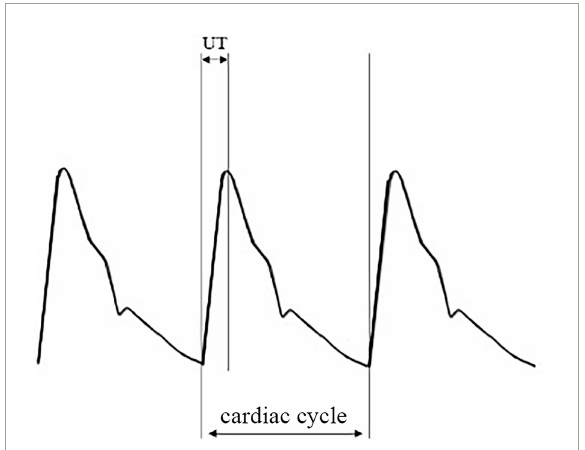
FIGURE1 An illustration of pulse volume recording (PVR) and its derivative parameters. PVR, pulse volume recording or pulse volume chart; UT, pulse wave upstroke time or pulse wave ascending time, which is the time required from the beginning to the peak of an arterial pulse wave in milliseconds (ms); UTCC, upstroke time per cardiac cycle time in